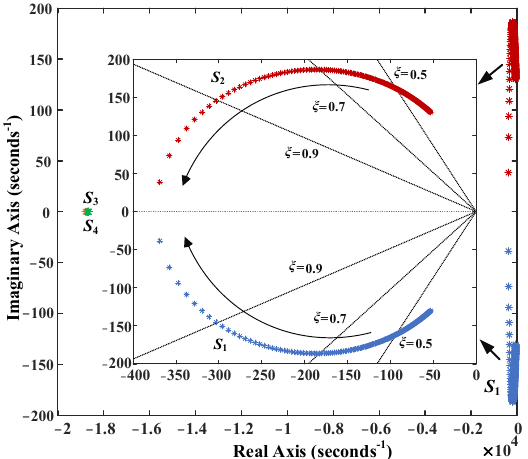
Figure 4. Characteristic root locus of the system with variation of M 3 .